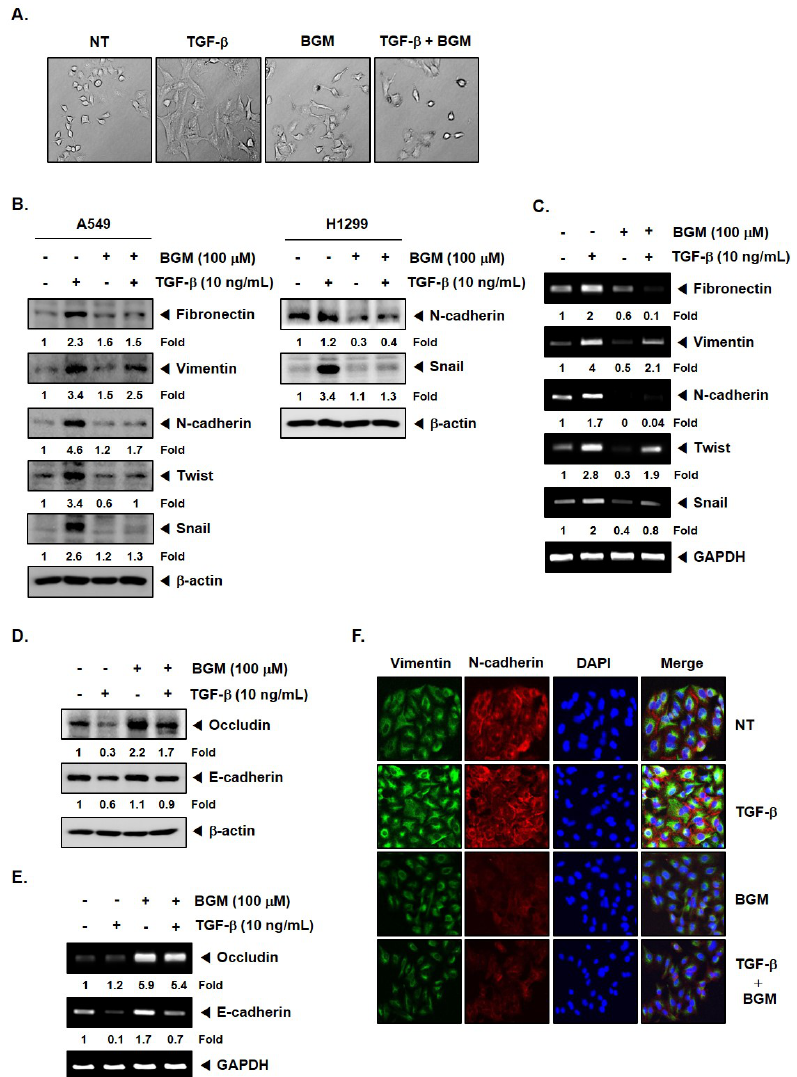
Figure 2. BGM blocks TGF- β -induced EMT process. ( A ) Phase-contrast microscopy for the